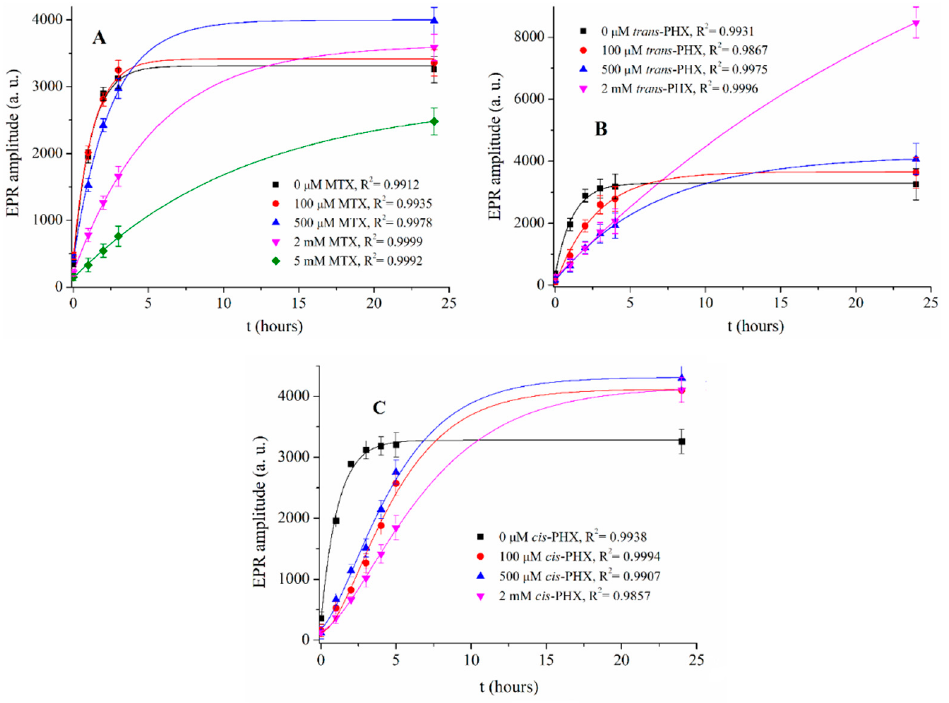
Figure 5. The amplitudes of EPR signals of samples containing 0–5 mM MTX ( A ), 0–2 mM trans -PHX ( B ) and, 0–2 mM cis -PHX ( C ) plotted against time.